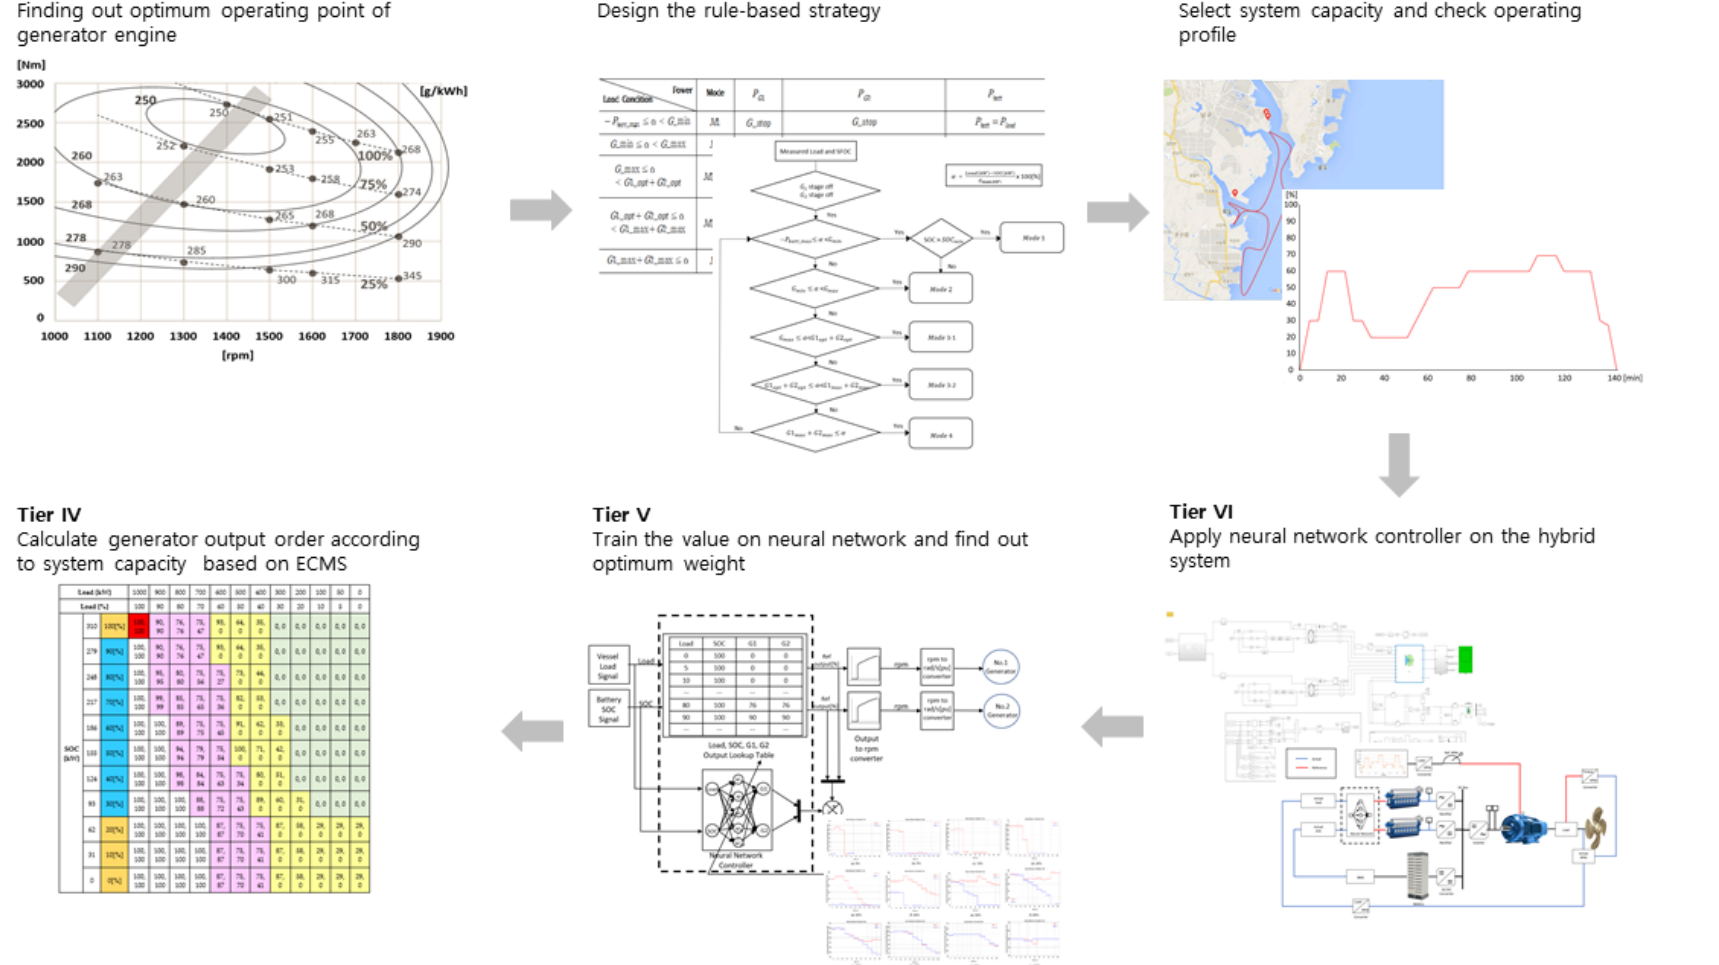
Figure 4. Design process of proposed generator–battery hybrid system with neural network.